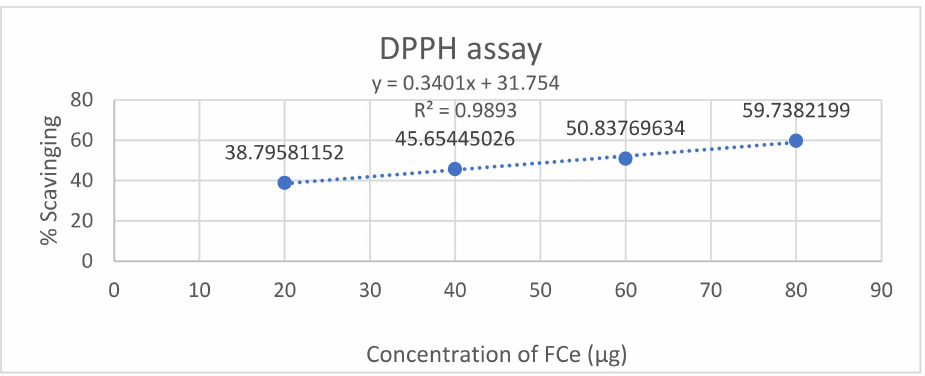
Figure 2. DPPH free radical scavenging activity of flower methanolic extract of P.